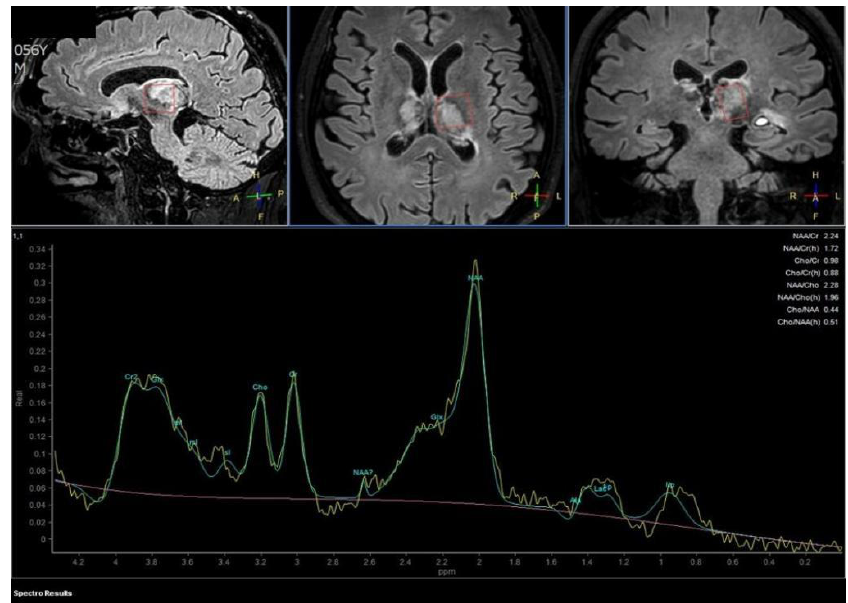
Figure 3. Proton MR Spectroscopy executed on the left thalamus demonstrates a normal spectrum of cellular metabolites, without anomalous metabolic peaks. The patient was soon candidate for anticoagulant therapy with Enoxaparin 6000 I.U./0.6 mL.